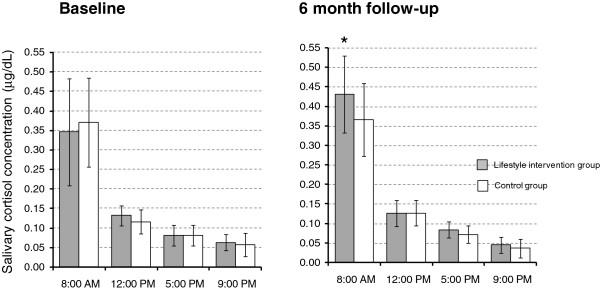
Diurnal salivary cortisol rhythm at baseline and 6-month follow-up. Values are medians with error bars representing semi-interquartile range (SIQR). *P = 0.03 for area under the curve (AUC) between groups.